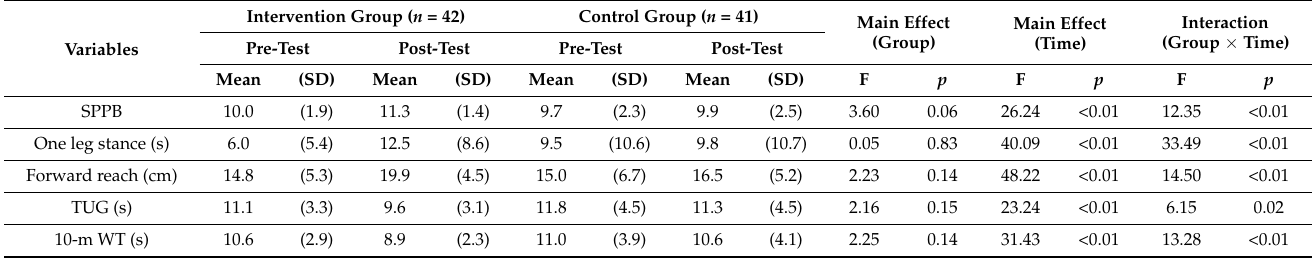
Table 3. Comparison of the physical performance tests between intervention and control